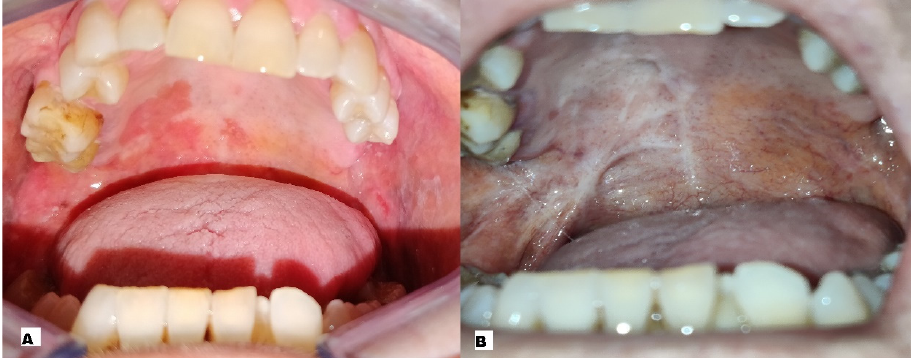
Figure 2. ( A ) Pre ‐ treatment image showing oral squamous cell carcinoma such as an erythematous Figure 2. ( A ) Pre-treatment image showing oral squamous cell carcinoma such as an erythematous non ‐ bleeding de ‐ epithelialised area with jagged margins, of the palate; ( B ) post ‐ treatment image non-bleeding de-epithelialised area with jagged margins, of the palate; ( B ) post-treatment image showing scarring from a biopsy and ECT with no sign of malignancy. showing scarring from a biopsy and ECT with no sign of malignancy.